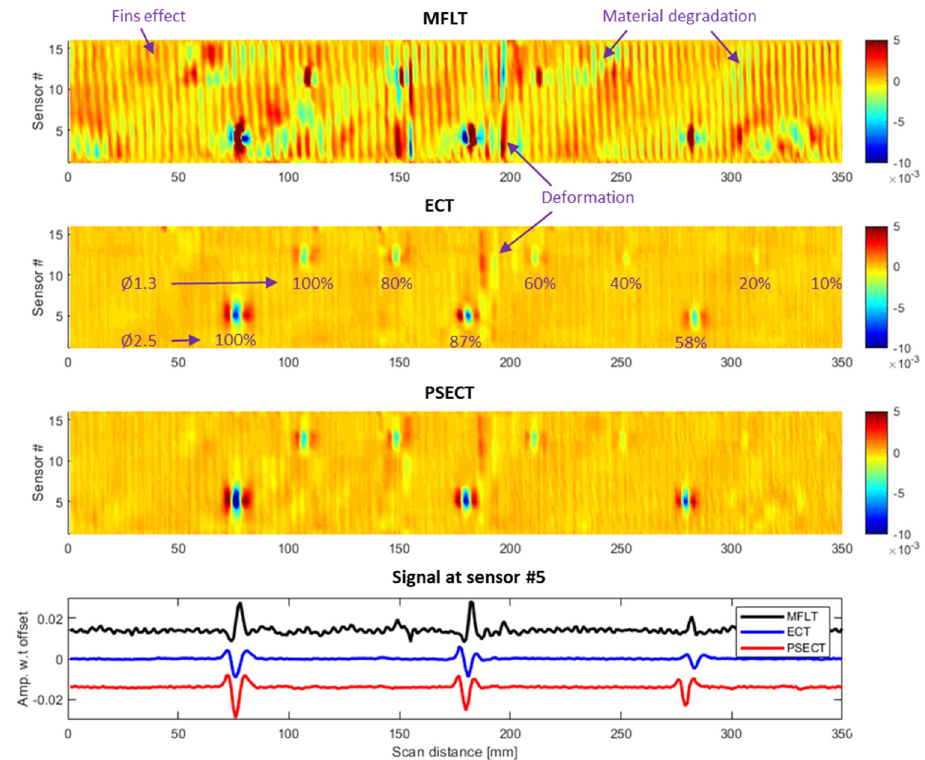
Figure 5. Di ff erential magnetic scanned signal of the MFLT, ECT and PSECT methods on the MSR Figure 5. Differential magnetic scanned signal of the MFLT, ECT and PSECT methods on the MSR finned tube and the section view at the holes of 2.5 mm diameter (sensor finned tube and the section view at the holes of 2.5 mm diameter (sensor #5).